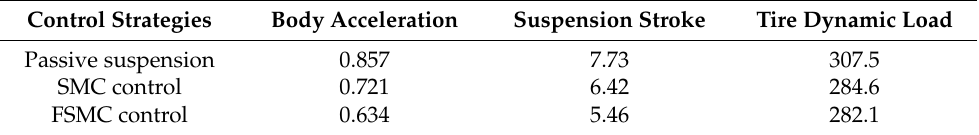
Table 4. RMS values of suspension system indexes under random road excitation.